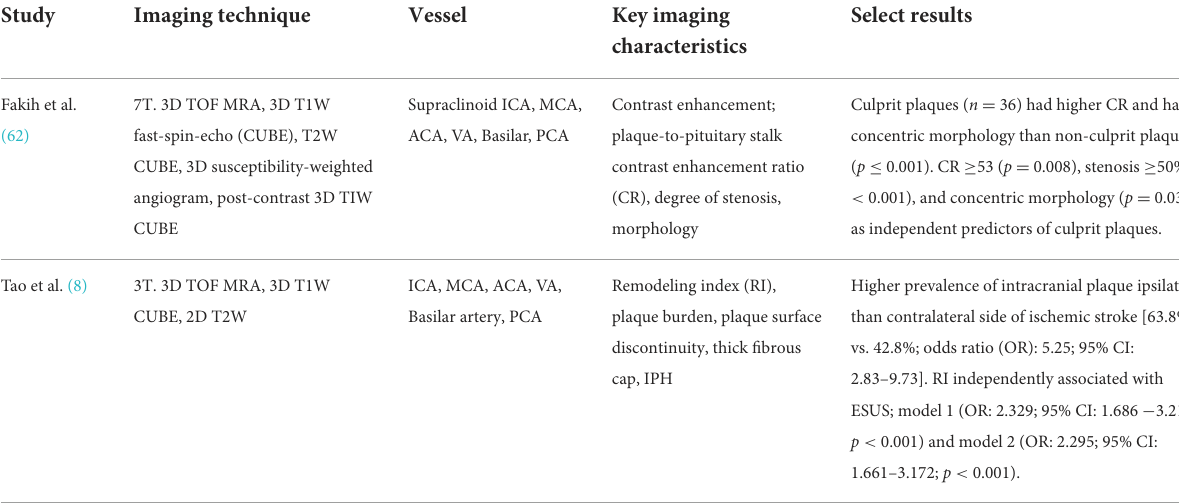
TABLE 3 Select studies using VW-MRI in an ESUS/CS population for evaluation of intracranial atherosclerosis. Study